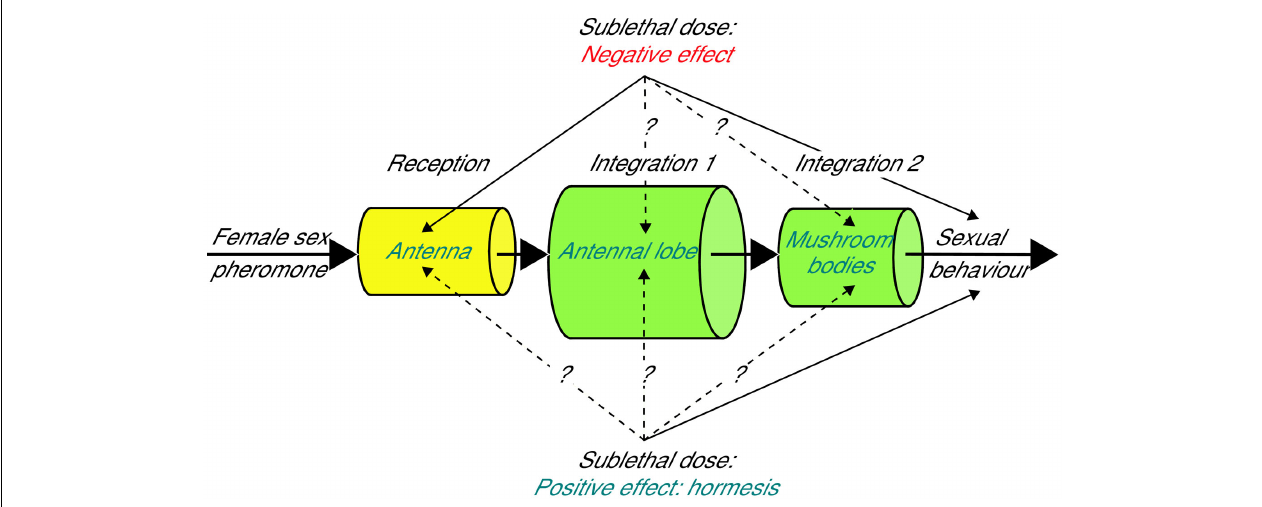
FIGURE 1 | Schematic representation of the observed and suspected effects of sublethal doses of insecticides on the olfactory system of